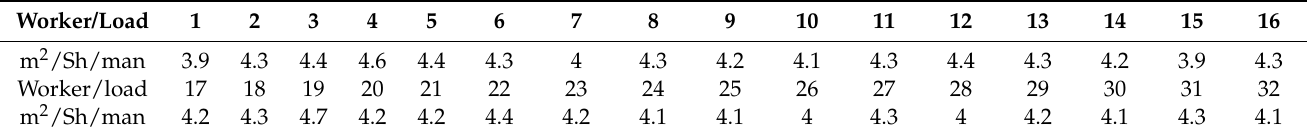
Table 8. Façade works—performance m 2 /Sh/man.